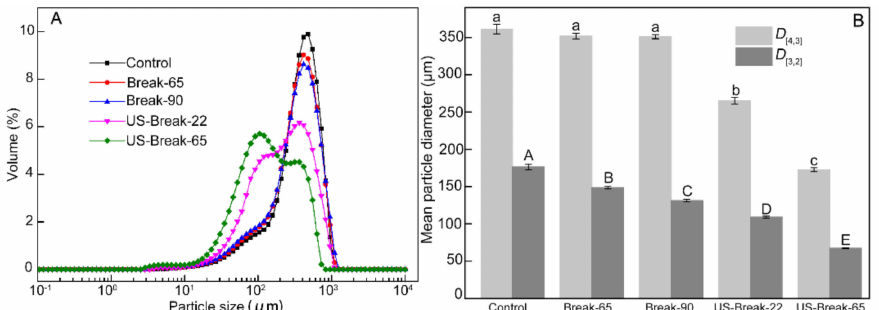
Figure 3. Effects of different breaking treatments on particle size distribution ( A ) and mean particle diameter size ( B ) of tomato paste. Break-65, Break-90, US-Break-22 and US-Break-65 refer to the thermal break at 65 ◦ C for 10 min, thermal break at 90 ◦ C for 10 min, ultrasound break at 22 ◦ C for 10 min, and ultrasound break at 65 ◦ C for 10 min, respectively. D [4,3] and D [3,2] represent the volume-based mean diameter and area-based mean diameter, respectively. a–c D [4,3] data bearing different lowercase letters were significantly different ( p < 0.05). A–E D [3,2] data bearing capital letters were significantly different ( p <